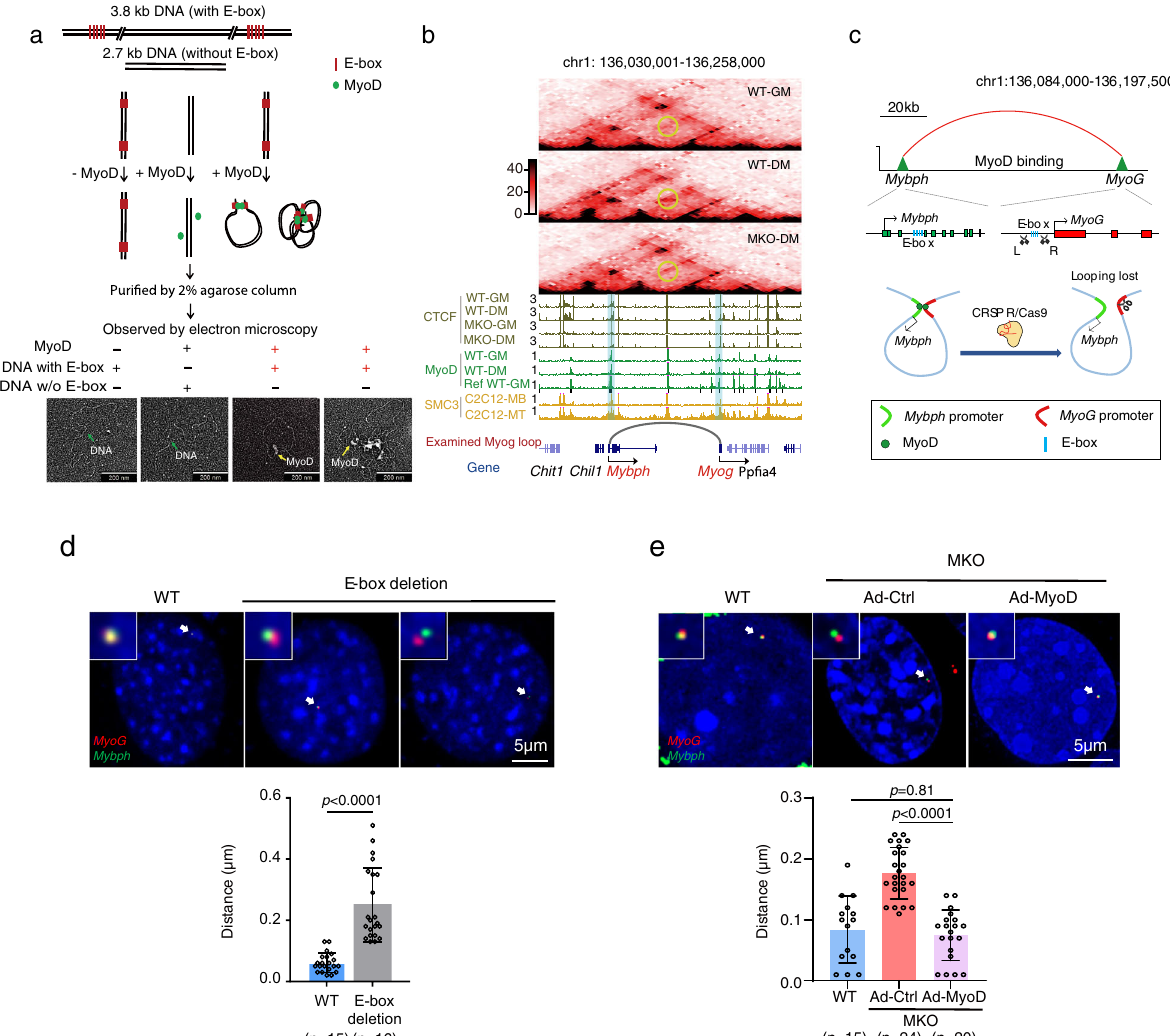
Fig. 3 MyoD directly instructs chromatin looping dependent on the E-box. a MyoD mediates chromatin looping in vitro. The upper panel presents a schematic for the in vitro DNA circularization assay used to detect the ability of MyoD (green) to mediate DNA looping with E-box (red)-containing DNA (3.8 kb) and the no-E-box control (2.7 kb). The lower panel presents representative views of circularized DNA mediated by recombinant MyoD protein, as imaged by transmission electron microscopy (TEM). The images are representative of three independent experiments. b Hi-C contact map depicting normalized contact frequencies and ChIP-seq signal tracks for a MyoD-bound chromatin loop at the MyoG locus. The examined chromatin loop, which shows reduced Hi-C contacts in the MKO-DM sample compared with the WT-DM sample, is marked by a yellow circle. c Schematic showing CRISPR/ Cas9-mediated deletion of the MyoD E-box in the regulatory region of the MyoG locus. d Representative images of 3D-DNA fl uorescent in situ hybridization (3D-DNA FISH) in WT and E-box-deleted cells (described in c ) cultured in DM. The upper panel shows that the MyoG promoter (red) and Mybph promoter (green) are separated by more in the E-box-deleted cells than in the WT cells. The lower panel showed the distance between the MyoG- Mybph loop anchors. The scale bar represents 5 μ m. Data are presented as mean ± SEM. p -values were determined using unpaired two-tailed Student ’ s t -test, *** p < 0.001. Source data are provided as a Source Data fi le. e Representative dCas9-mediated DNA imaging (upper panel), which was used to visualize the chromatin loop anchors described in b . The distances between the two anchors were measured (lower panel). MKO cells were infected with adenovirus expressing MyoD (Ad-MyoD) or Ad-EGFP (control, Ad-Ctrl). The chromatin loopings at MyoG (red) and Mybph (green) loci were visualized by dCas9-mediated DNA imaging. DAPI served to visualize nuclei. The scale bar represents 5 μ m. Data are presented as mean ± SEM. p -values were determined by performing ANOVA followed by Tukey ’ s multiple comparison test, *** p < 0.001. Source data are provided as a Source Data fi WT and MKO proliferating cells. MyoD binding was found to be enriched on the anchors of chromatin loops with reduced internal interactions (65%) in MKO-GM cells compared with WT-GM cells (Fig. 5a, b), indicating that MyoD regulates the internal interactions within chromatin loops by its direct binding on loop anchors, as also seen for CTCF and cohesin. Further analysis showed that interactions changes within chromatin loops were positively correlated with expression changes of the genes within those loops (Fig. 5c).